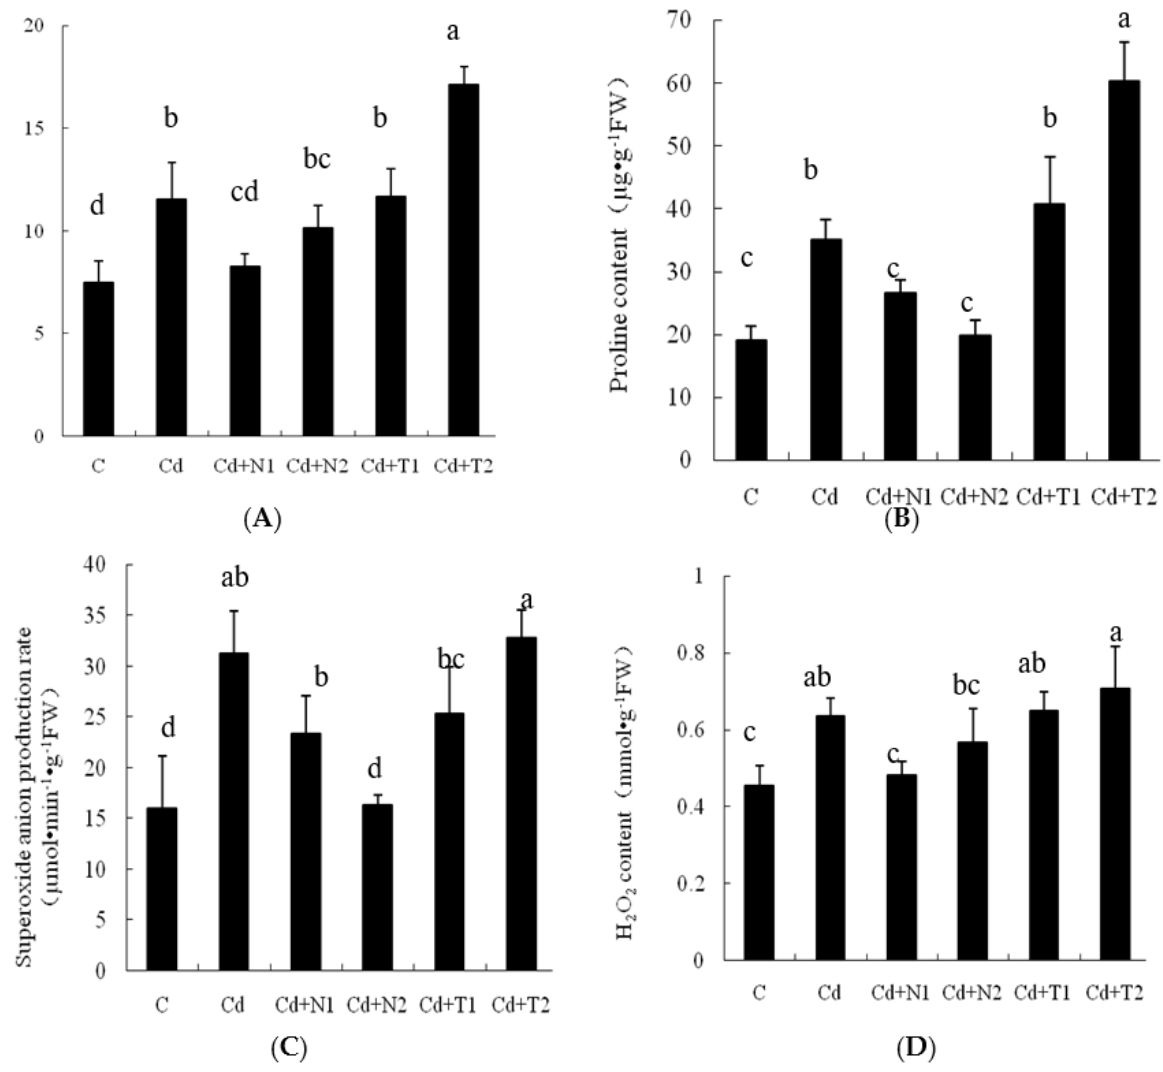
Figure 2. MDA contents ( A ), proline contents ( B ), superoxide anion (O 2 − ) production rate ( C ), and H 2 O 2 ( D ) content in leaves of tomato plants under Cd stress.C: 0 µ MCd; Cd: 50 µ MCd; Cd + N1: 50 µ M Cd + 0.5 µ M NAA; Cd + N2: 50 µ M Cd + 1 µ M NAA; Cd + T1: 50 µ M Cd + 100 µ M TIBA; Cd + T2: 50 µ M Cd + 200 µ M TIBA; MDA: malondialdehyde; H 2 O 2 : hydrogen peroxide; FW: fresh weight. The lowercase letters indicate the significant differences at 5% level.